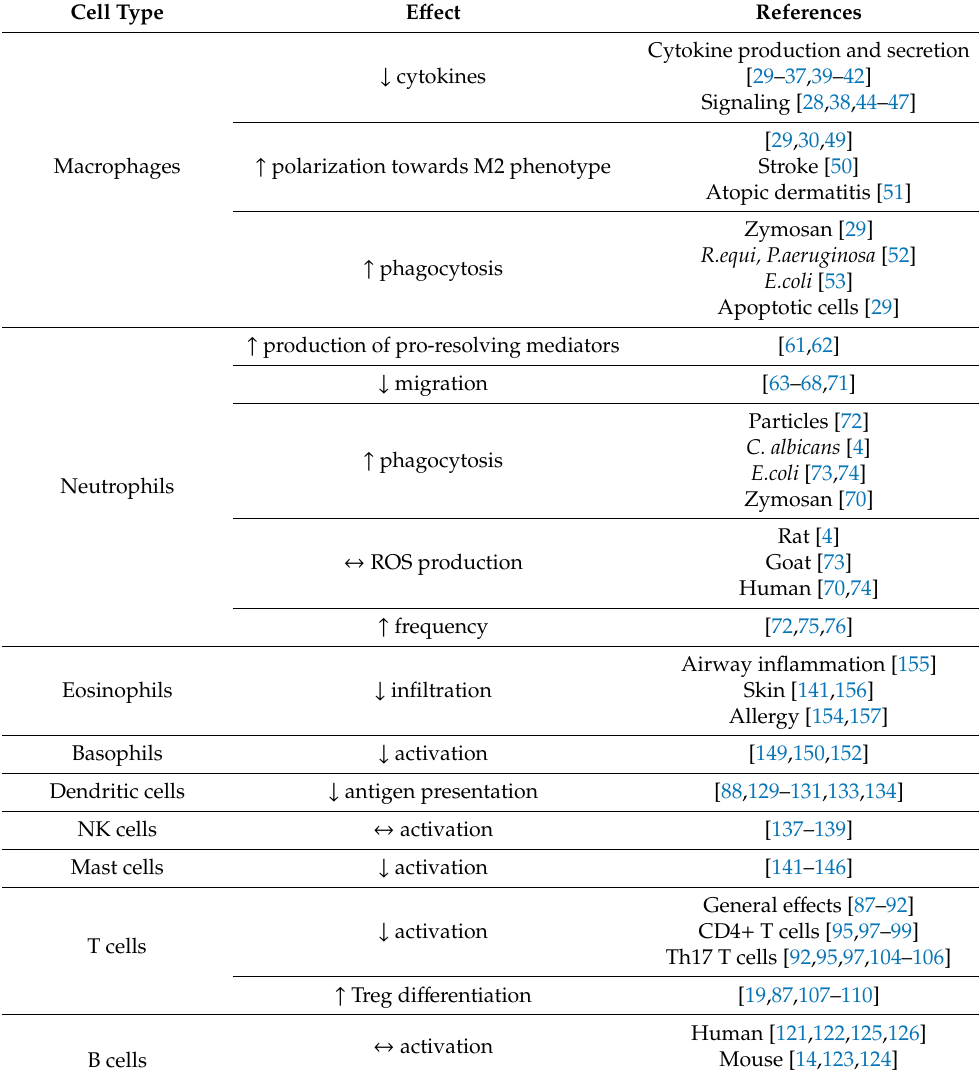
Table 1. Summary of the properties of omega-3 fatty acids and their mediators on the di ff erent cells of the immune system including main